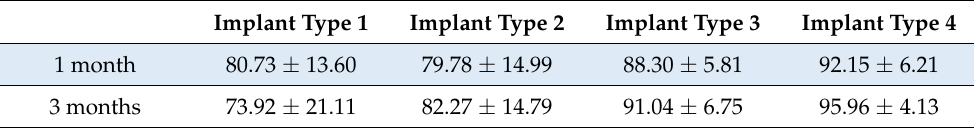
Table 2. Coronal aspect bone-to-implant contact (BIC) after one month (1 m) and 3 months (3 m) of healing. Values after 1 month and 3 months of healing are presented as the average (%) ±